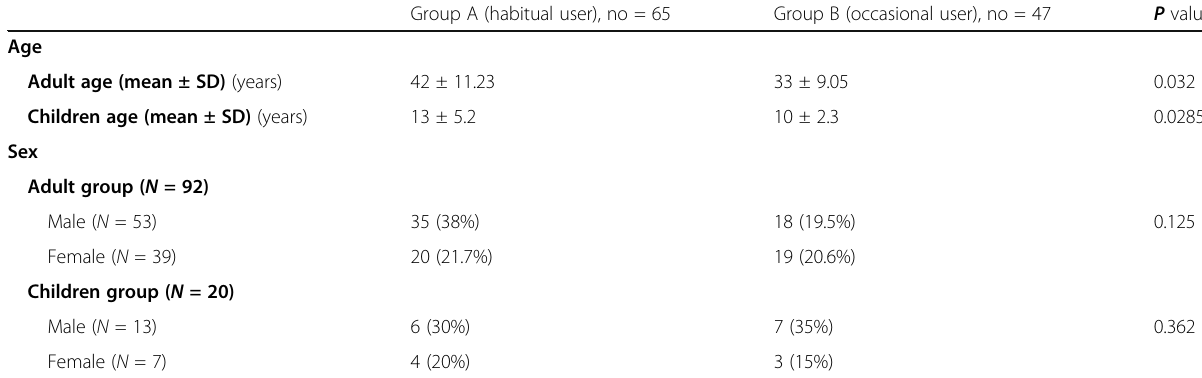
Table 1 Demographic data in studied population